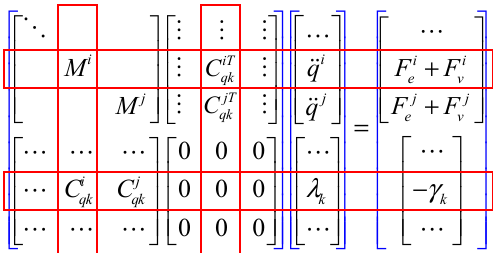
Figure 7. Rigid body removal method from the dynamic equations.